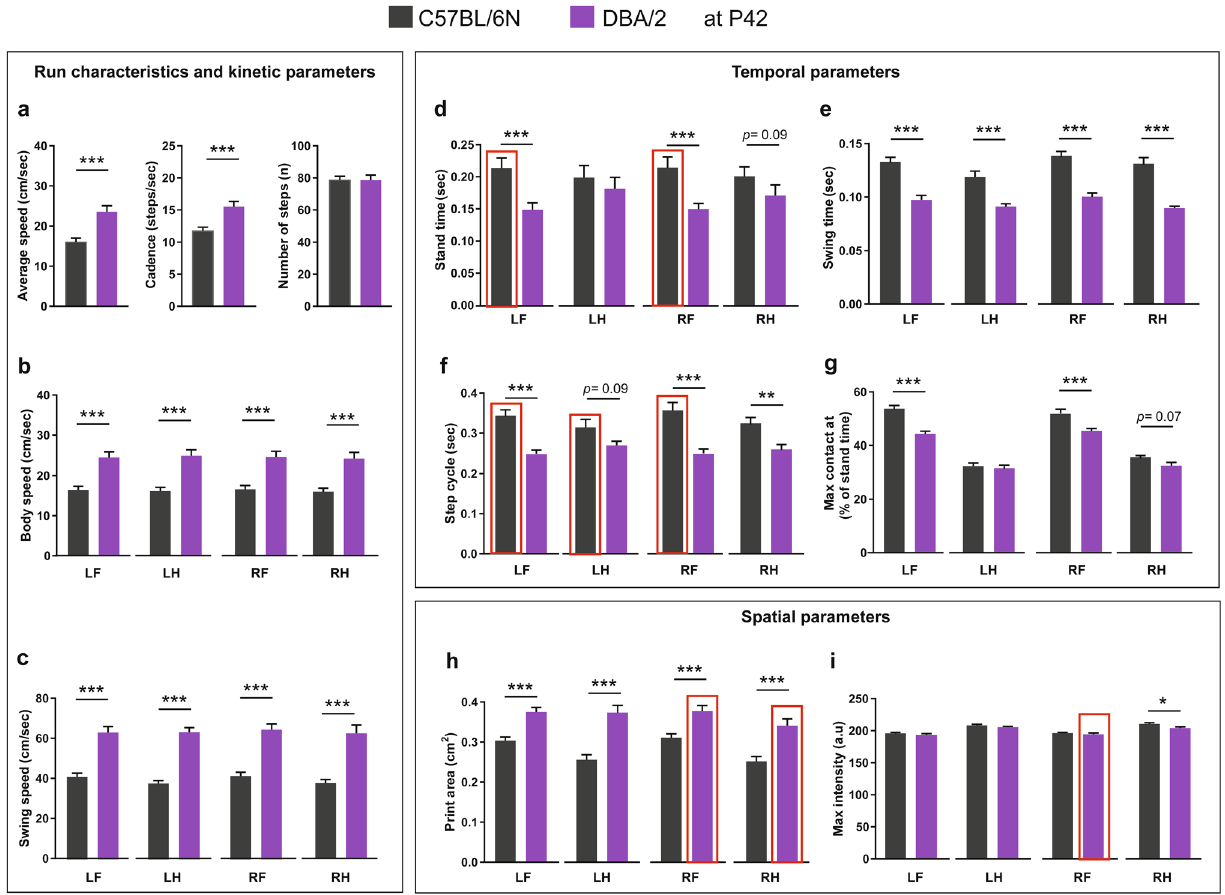
Figure 4. Comparison of run characteristics and kinetic, temporal and spatial parameters between C57BL/6N and DBA/2 mice at P42. ( a ) DBA/2 mice showed a significant increase in the average speed and cadence, but no difference in the number of steps compared to C57BL/6N mice. ( b , c ) DBA/2 mice showed an increase in the body speed ( b ) and swing speed ( c ) of all paws compared to C57BL/6N mice. ( d ) DBA/2 mice showed a significant decrease in the stand time of LF and RF paws. ( e ) DBA/2 mice showed a significant decrease in the swing time of all paws. ( f ) DBA/2 mice showed a significant decrease in the step cycle of LF, RF and RH paws. ( g ) DBA/2 mice showed a significant decrease in the maximum contact at (%) of both LF and RF paws compared to C57BL/6N mice. ( h , i ) DBA/2 mice showed an increase in the print area of all paws ( h ) and a decrease in the maximum intensity of the RH paw compared to C57BL/6N mice. ( i ). Two-way ANOVA followed by Bonferroni post hoc test, * p ≤ 0.05, ** p ≤ 0.01, *** p ≤ 0.001. A red rectangle indicates a significant difference between sexes within a strain (see Supplementary Table S1). Error bars indicate the standard error of the mean (SEM). RF right front, LF left front, RH right hind, LH left